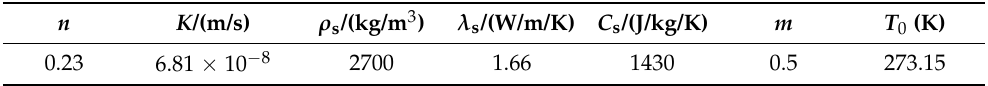
Figure 3. Distribution of thermal couple along the fracture face (adapted from reference [24]). Table 2. Physical and thermodynamic parameters related to the rock sample (adapted from reference